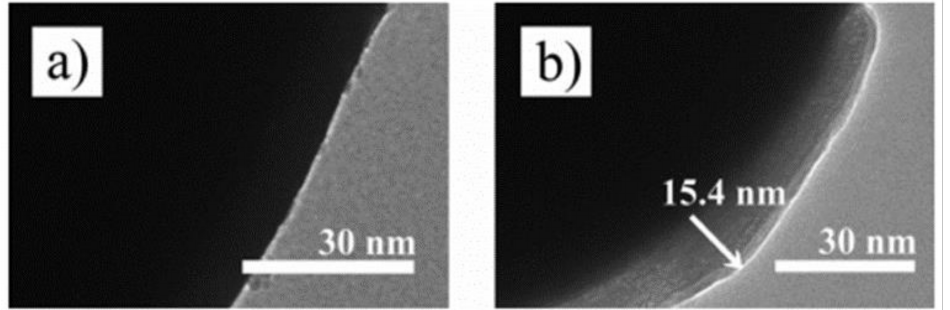
Figure 9. TEM images of ( a ) bare CI and ( b ) a single particle of CI-g-poly(trimethylsilyloxy)ethyl methacrylate (Mordina et al. [86], ©American Chemical Society,